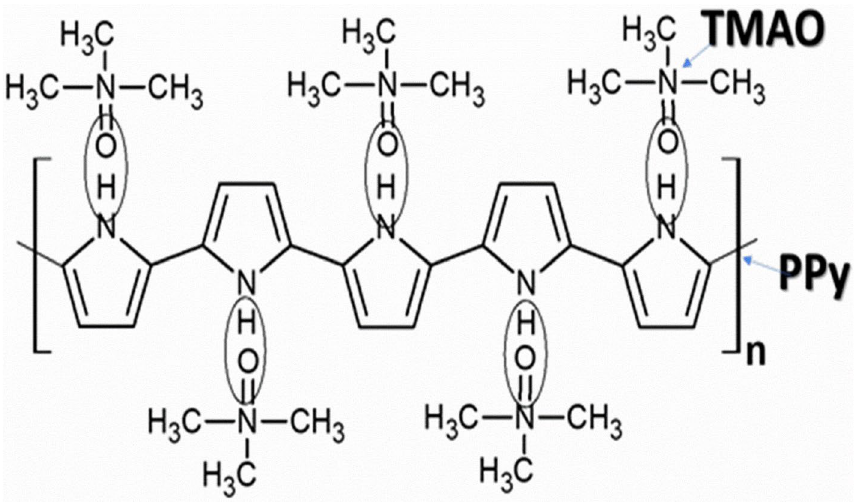
Figure 4. Chemical interaction between TMAO and PPy. The interaction between the N-oxide of TMAO and PPy occurs by formation of hydrogen bonds between NH of PPy and oxygen atoms in N-oxides. When TMAO was added at different concentrations, the NH groups started binding with the oxygen of TMAO, thereby leading to a decrease in the electro-activity and peak current in the response study. The image was created